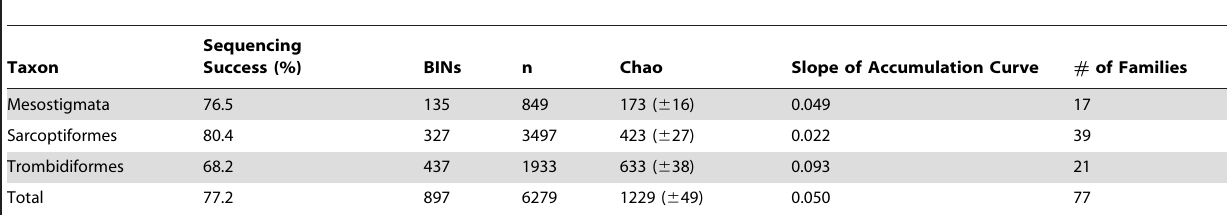
Table 1. Observed and expected BIN richness for each order, as calculated by Chao’s estimator in R including error ( 6 SE)